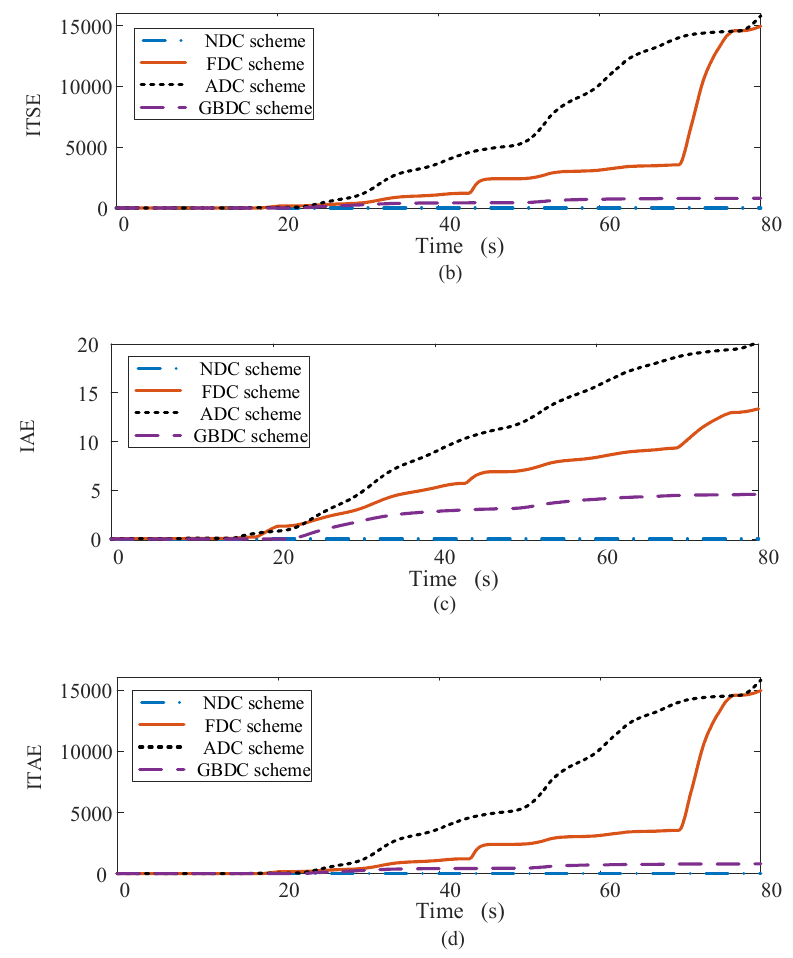
Figure 17. Indices of pitch angle deviation: ( a ) ISE; ( b ) ITSE; ( c ) IAE; ( d ) ITAE.